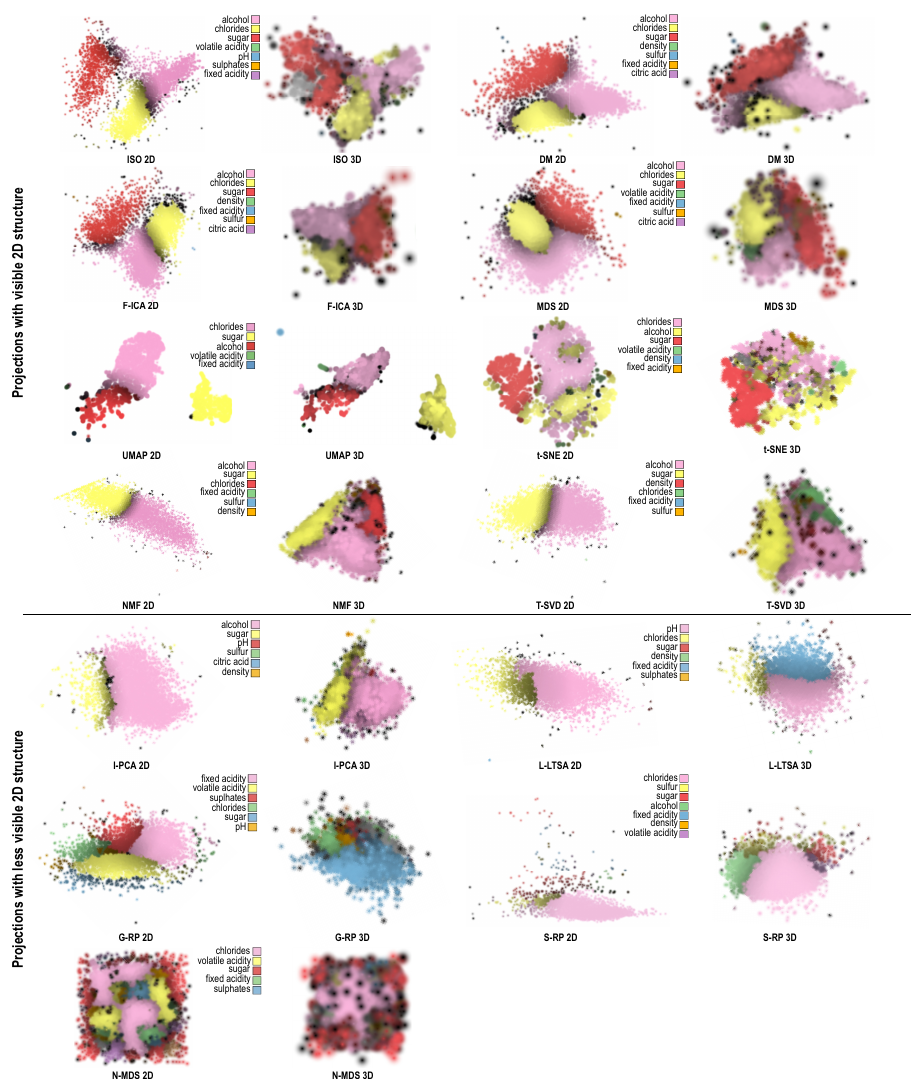
Figure 5. Comparison of 2D and 3D projections, Wine dataset. Same as Figure 4, but using the same dimension-to-color mapping for 2D and 3D projections created by the same